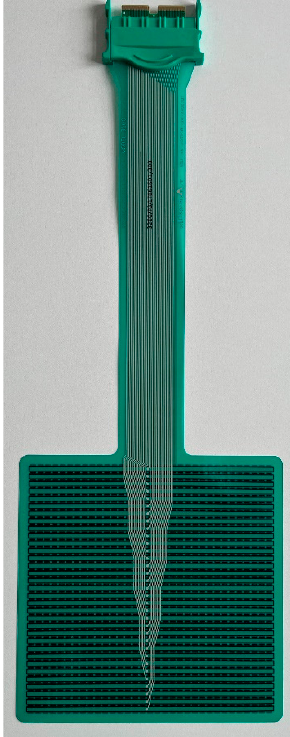
Figure 2. Sensor foil of the Hoof™ System.